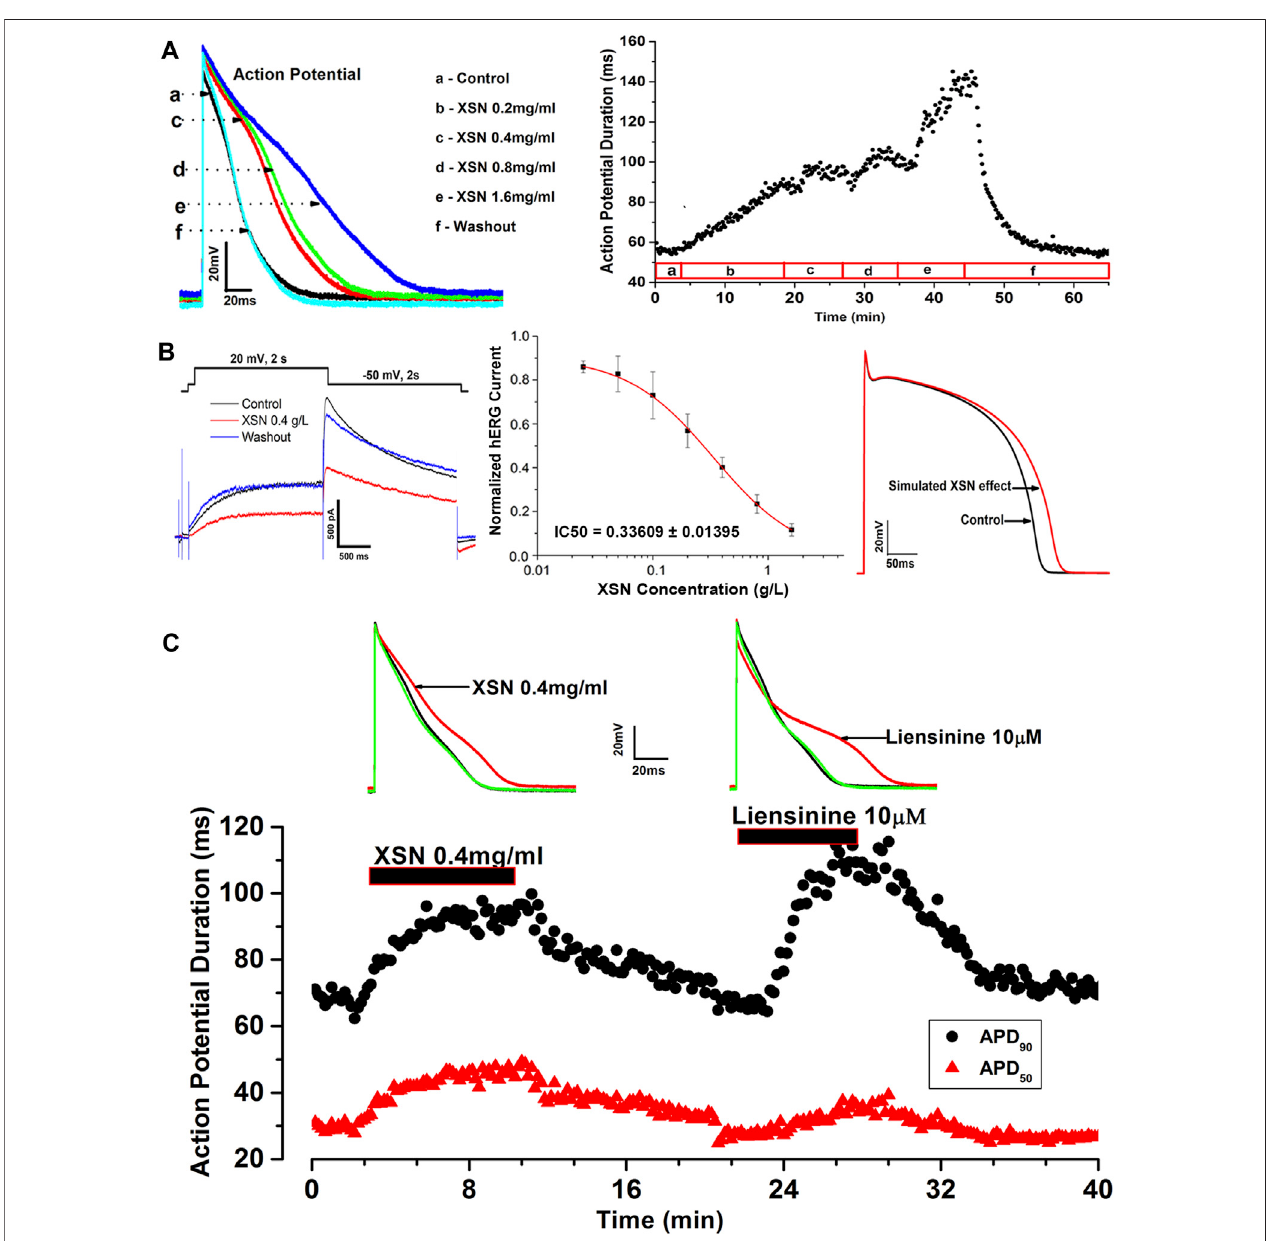
FIGURE1| EffectofXSNandliensinineonAPDofcardiacmyocytesandcomputationalsimulationofhumanAP. (A) Dataplotshowstheconcentration-dependent and reversible effect ofXSN on APD, from which the superimposed AP traces were extracted to show the effect ofXSN at various concentrations indicated by the keys. (B) XSNreversiblyblocksthehERGchannelinadose-dependentmannerwithanIC 50 of0.34 mg/mlasthekeysindicated,whichwasusedtosimulatetheeffectofXSN on human AP. (C) Shows the comparative effect of XSN and liensinine on APD (Ma et al., 2020).